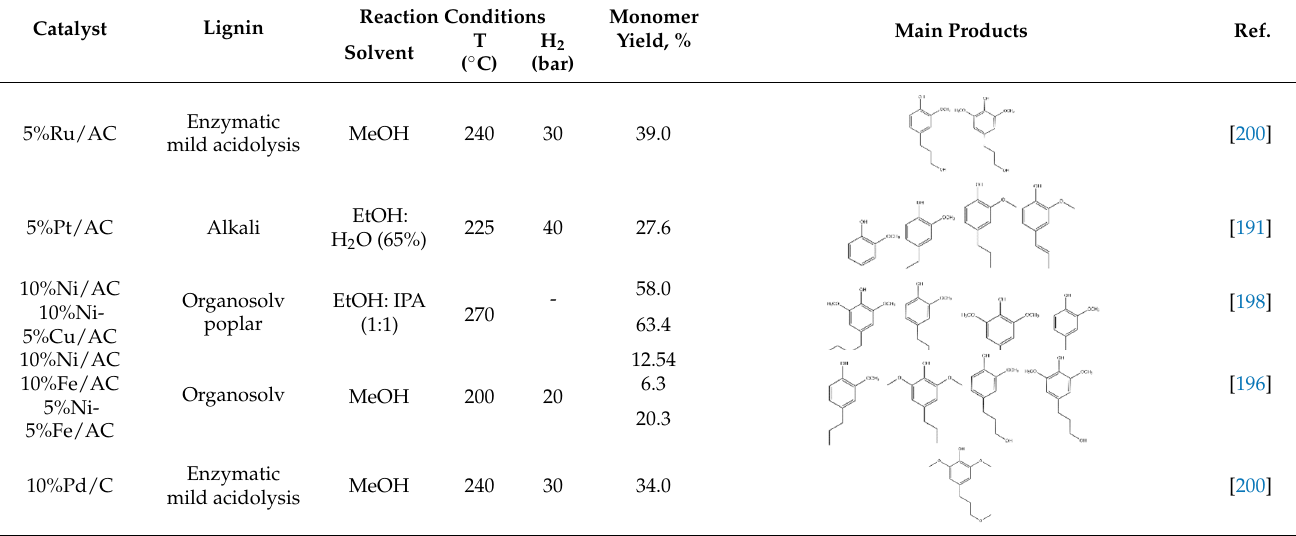
Figure 8. The possible bonding configurations of N atoms. Reprinted with permission from Ref. [202]. Copyright 2019, American Chemical Society.